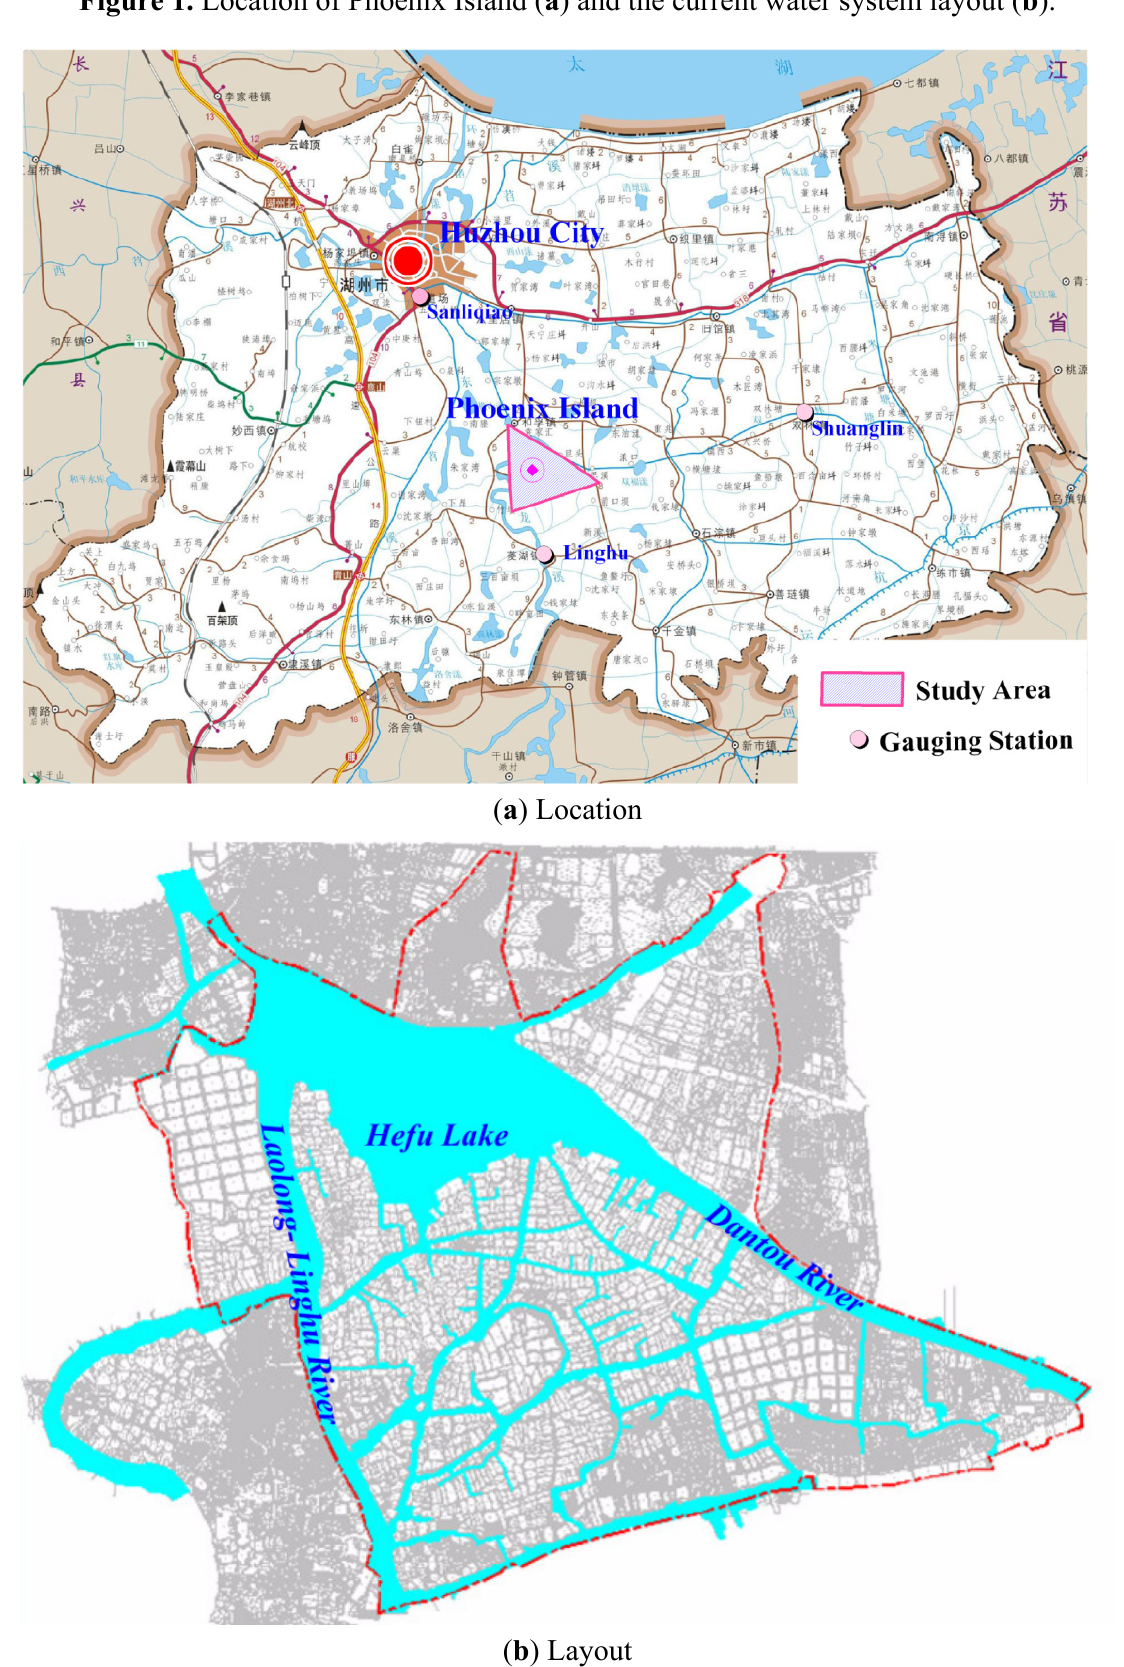
Figure 1. Location of Phoenix Island ( a ) and the current water system layout ( b